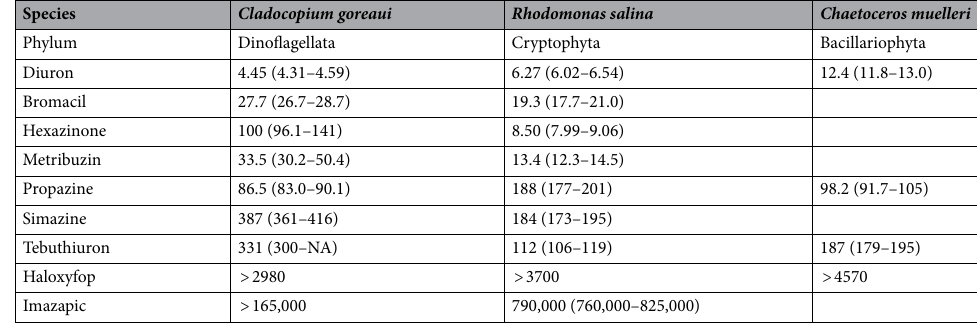
Table 3. Comparison among toxicity thresholds of Cladocopium goreaui, Rhodomonas salina and Chaetoceros muelleri . Effect concentration values (SGR EC 50 ) with 95% confidence intervals derived for Cladocopium goreaui, Rhodomonas salina and Chaetoceros muelleri exposed to herbicides. All experiments were conducted under similar conditions in the same laboratory. Concentrations are reported in µg L −1 . EC 50 values for Rhodomonas salina obtained from Thomas et al. 23 and Chaetoceros muelleri from Thomas et al. 38